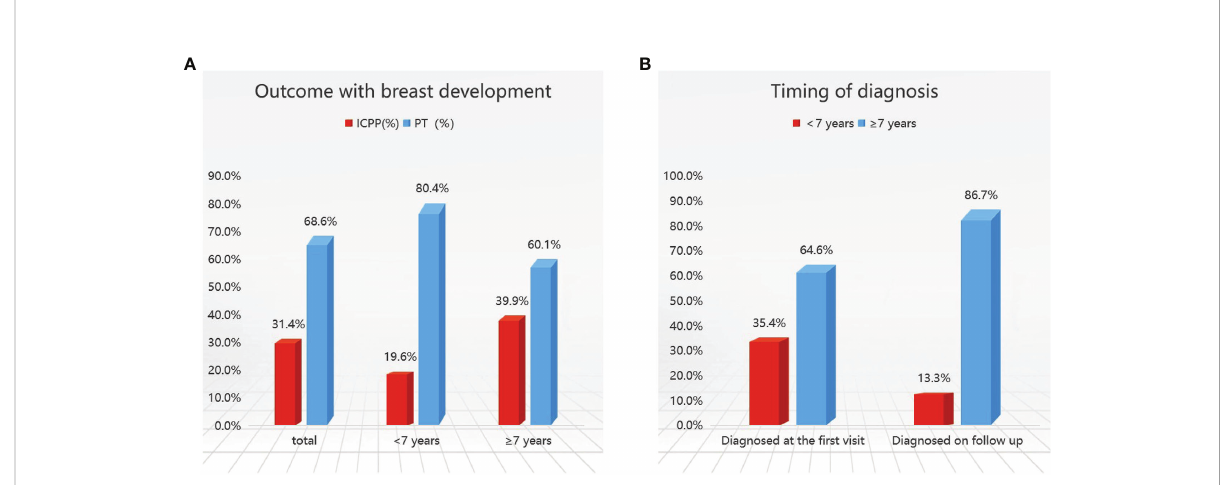
FIGURE 2 Outcomes (A) and timing of diagnosis (B) in girls with early breast development. ICPP, idiopathic central precocious puberty; PT, premature thelarche.